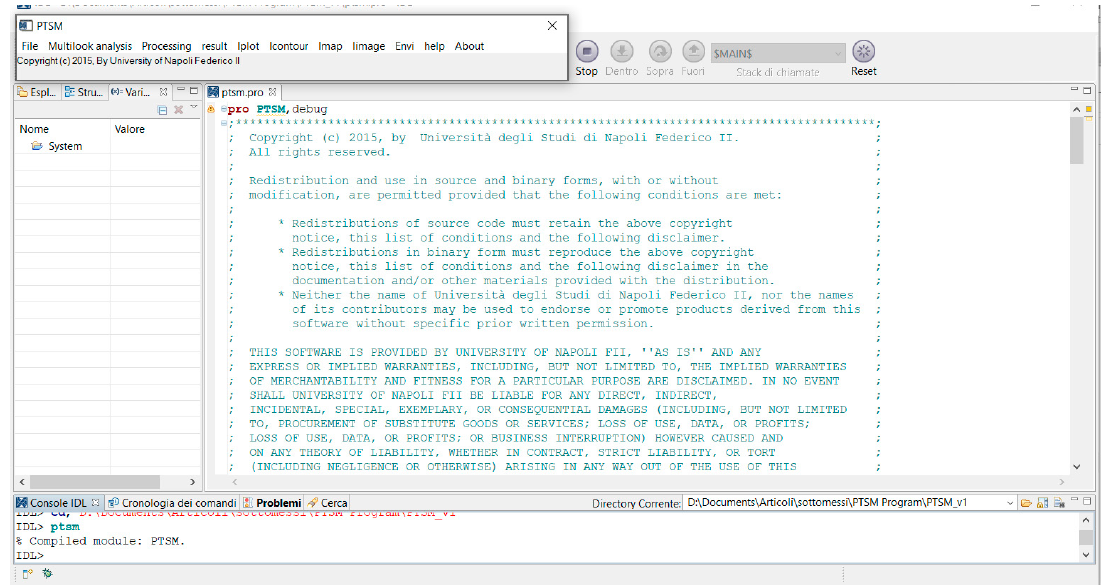
Figure 6. PTSM-OOP’s main window and copyright statements.